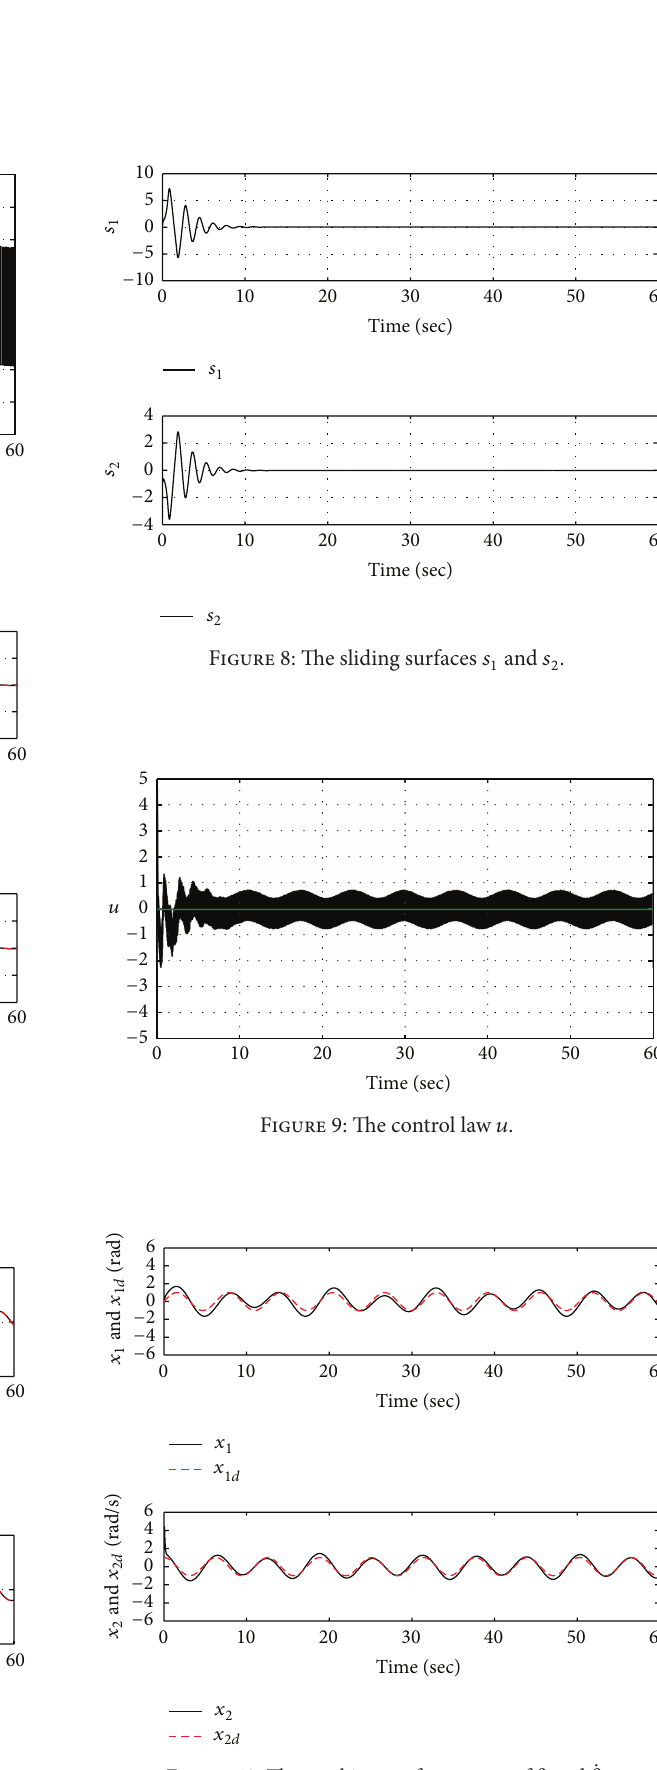
Figure 7: The tracking performances of 𝑥 and ̇𝑥 .